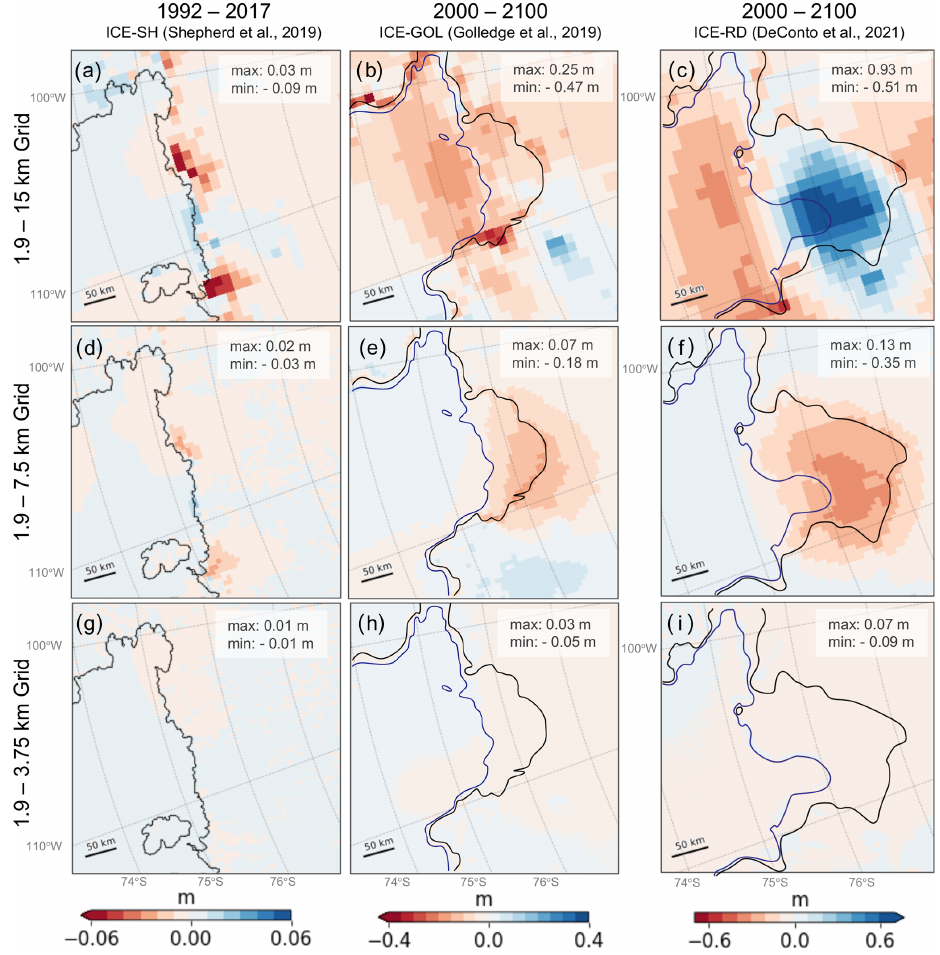
Figure 7. Influence of grid resolution on viscoelastic sea-level predictions in ASE. As in Fig. 4 but adopting the 3-D viscoelastic Earth model